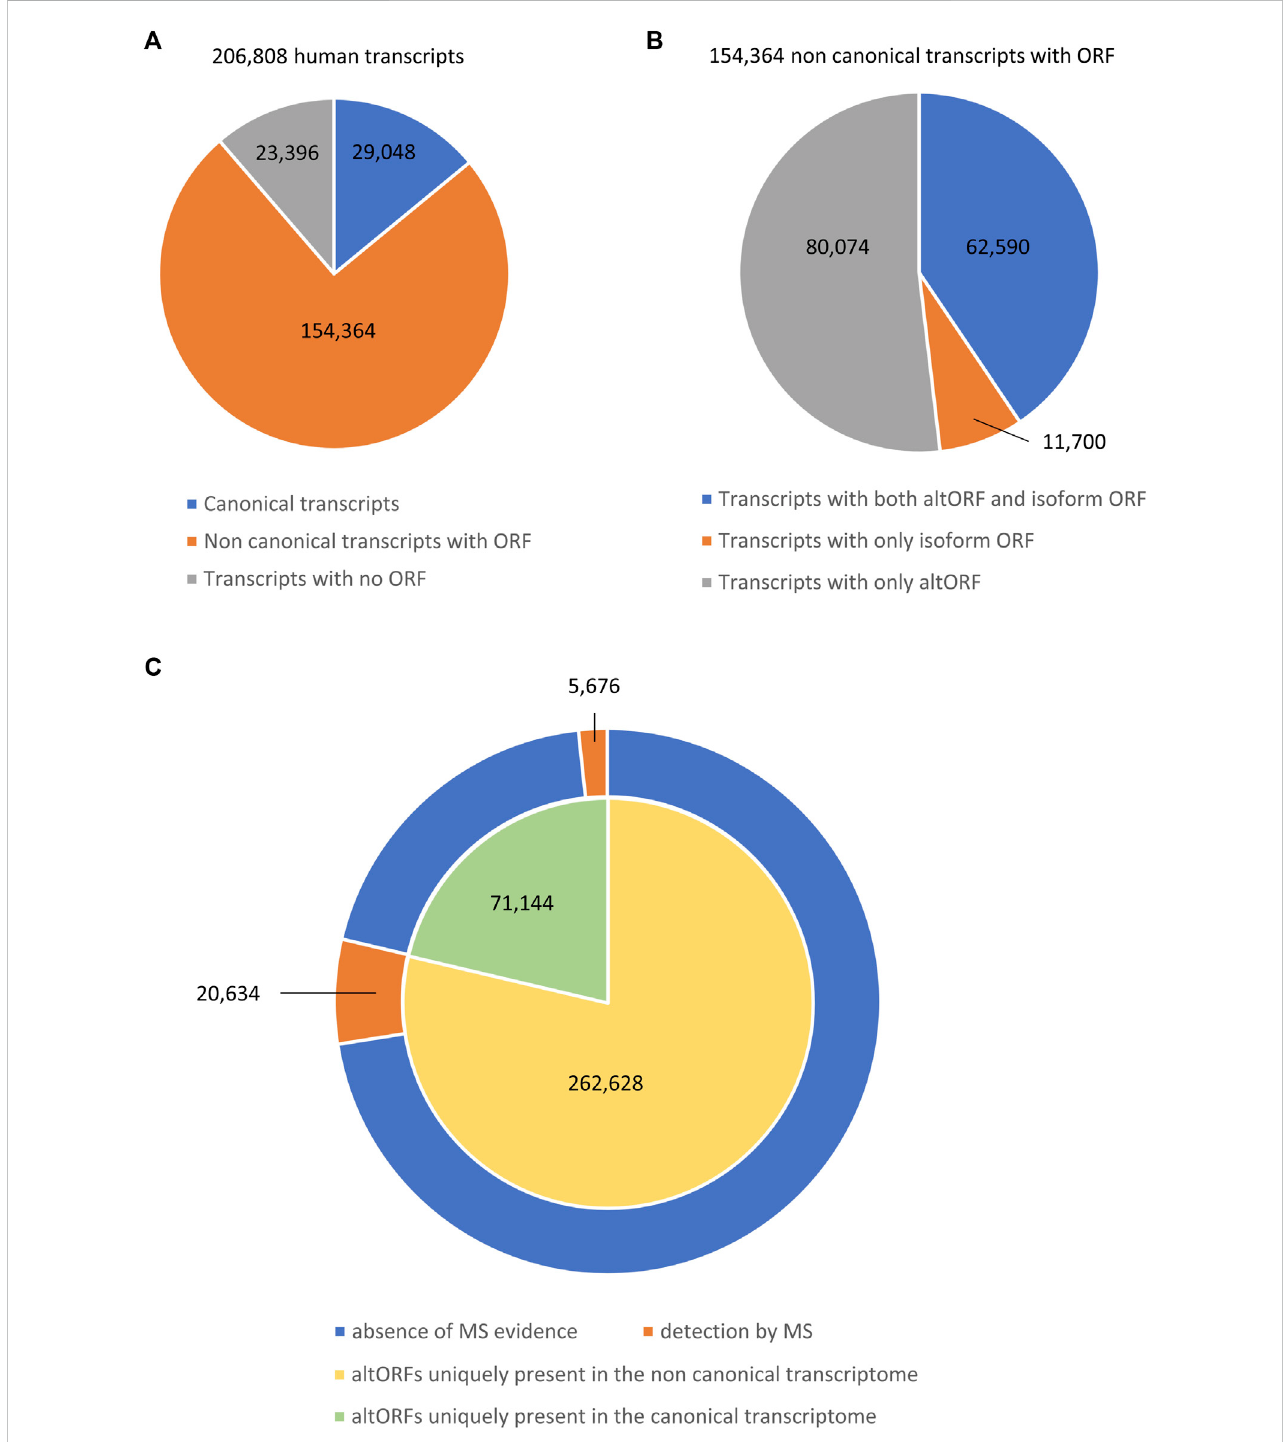
FIGURE 1 Composition of the human transcriptome. (A) Pie chart showing the number of different transcripts from the human reference genome (GRCh38 v95). Threetypesoftranscriptsarerepresented:canonicaltranscriptsencodingareferenceprotein(blue),non-canonicaltranscripts generatedthroughalternative splicing that contain an ORF (orange),and transcripts that do not have an annotated ORF (gray). (B) Pie chart showing theproportion of differentsub-types of non-canonical transcripts containing an ORF. Three sub-types of transcripts are represented: non-canonical transcripts with both an alternative ORF (altORF)andanisoformORF(blue),non-canonicaltranscriptswithonlyanisoformORF(orange),andnon-canonicaltranscriptswithonlyanaltORF(gray). (C) Double pie chart representing the distribution of altORFs uniquely present in the canonical transcriptome (green) or the non-canonical transcriptome (yellow). Using the OpenProt database (Brunet et al., 2019), the evidence obtained by mass spectrometry (MS) of altORF-related proteins is represented in orange in the ring, while the absence of evidence is represented in